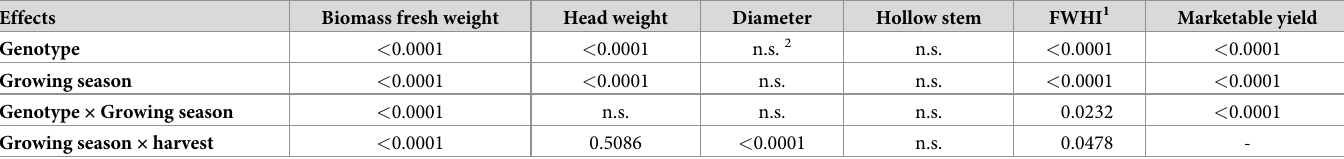
Table 2. Results from the analysis of variance for different agronomic traits.